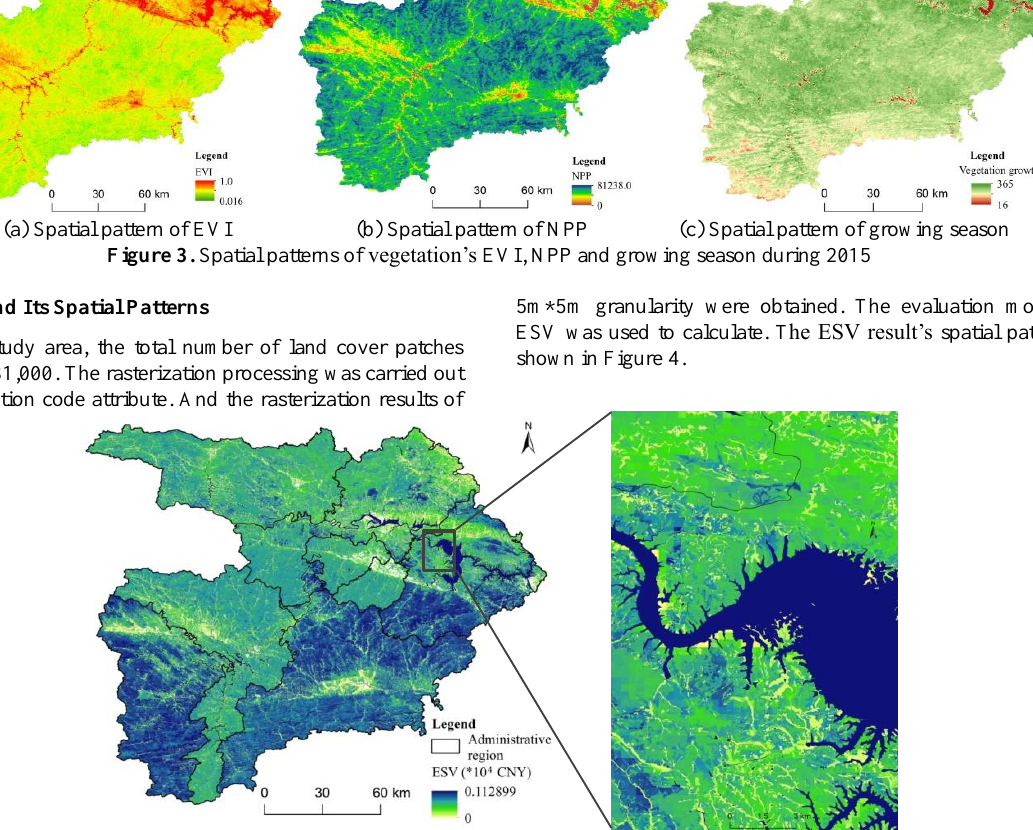
Figure 4. Spatial patterns of ESV and its local enlargement (5m*5m grid